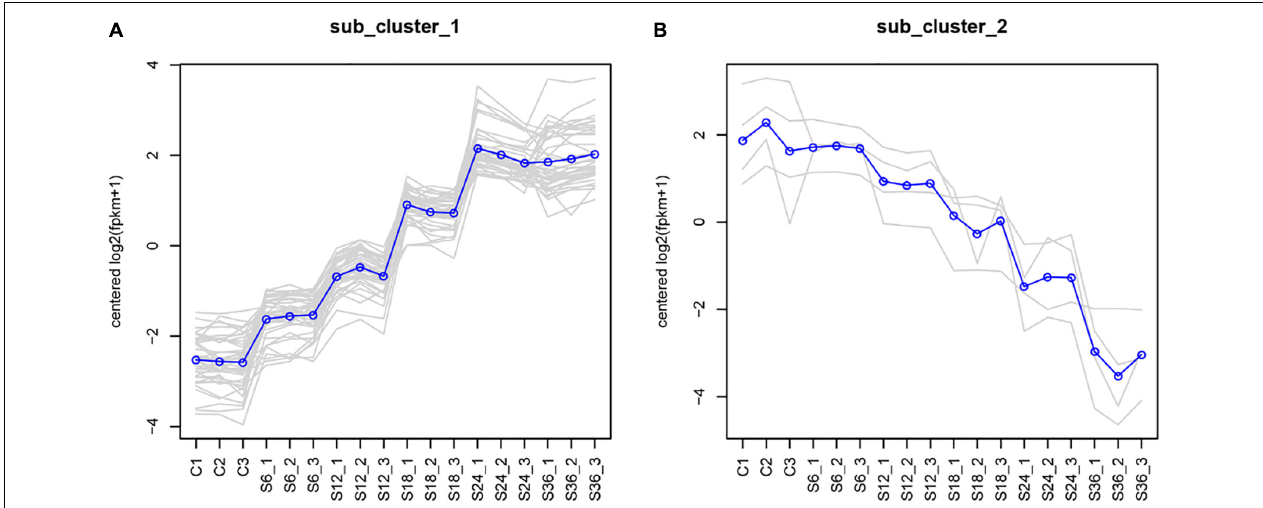
FIGURE 3 | Cluster line chart of five comparison groups. We used the H-cluster method to cluster the DEGs by taking log2 (fpkm + 1) and centralizing correction. The genes in the same cluster had similar expression levels under different treatment conditions. (A) DEGs with up-regulated expression trend. (B) DEGs with down-regulated expression trend. C1-3: control groups; S6_1-3: PK-15 cells at 6 h SVA post-infection groups; S12_1-3: PK-15 cells at 12 h SVA post-infection groups; S18_1-3: PK-15 cells at 18 h SVA post-infection groups; S24_1-3: PK-15 cells at 24 h SVA post-infection groups; S36_1-3: PK-15 cells at 36 h SVA post-infection groups.